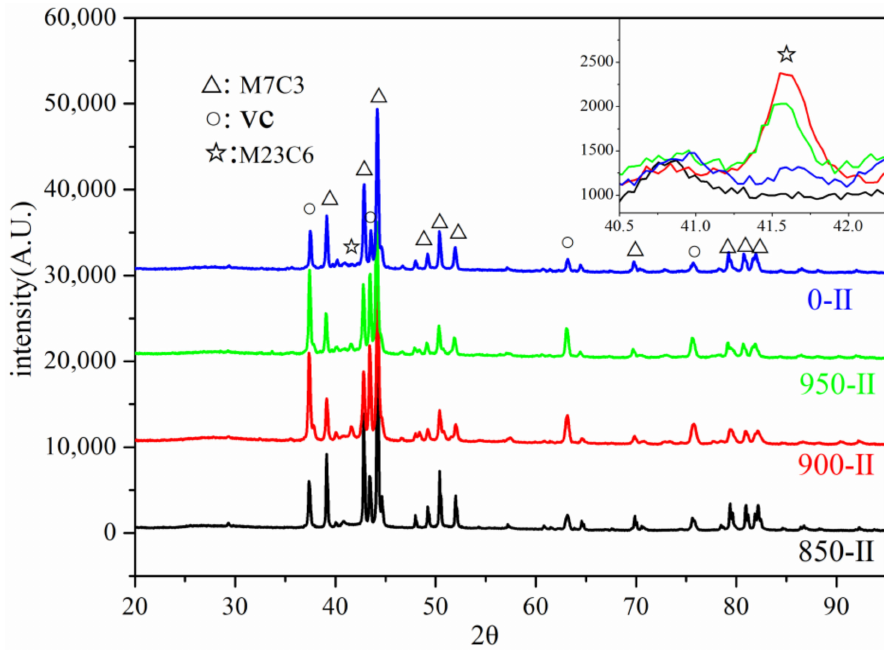
Figure 6. XRD patterns of electrolytic extraction products in stage II. The precipitate evolution of H13 steel during intercritical annealing and the microstruc- tures tested of 900-II were examined using the TEM. Figures 7 and 8 represent the TEM images of 900-II. The orientation relationship between carbides (M 23 C 6 , M 7 C 3 , and VC) and the matrix can be obtained by analyzing the diffraction spots of the selected area and the Fourier change of the high-resolution image. As an essential strengthening phase in steel, the MC phase is mainly a spherical face-centered cubic (FCC) structure. Generally speaking, when the MC-type precipitate of the FCC structure is precipitated in the matrix of the body-centered cubic (BCC) structure, the orientation relationship between the two becomes in line with the Baker–Nutting orientation relationship [25,26] ( 100 ) MC (cid:107) ( 100 ) α , [ 010 ] (cid:107) [ 110 ] α . The small size (<50 nm) of the VC and BCC matrix diffraction spots com- MC pletely overlap, namely: ( 100 ) VC (cid:107) ( 110 ) α , [ 001 ] VC (cid:107) [ 001 ] α , as shown in Figure 8b. This